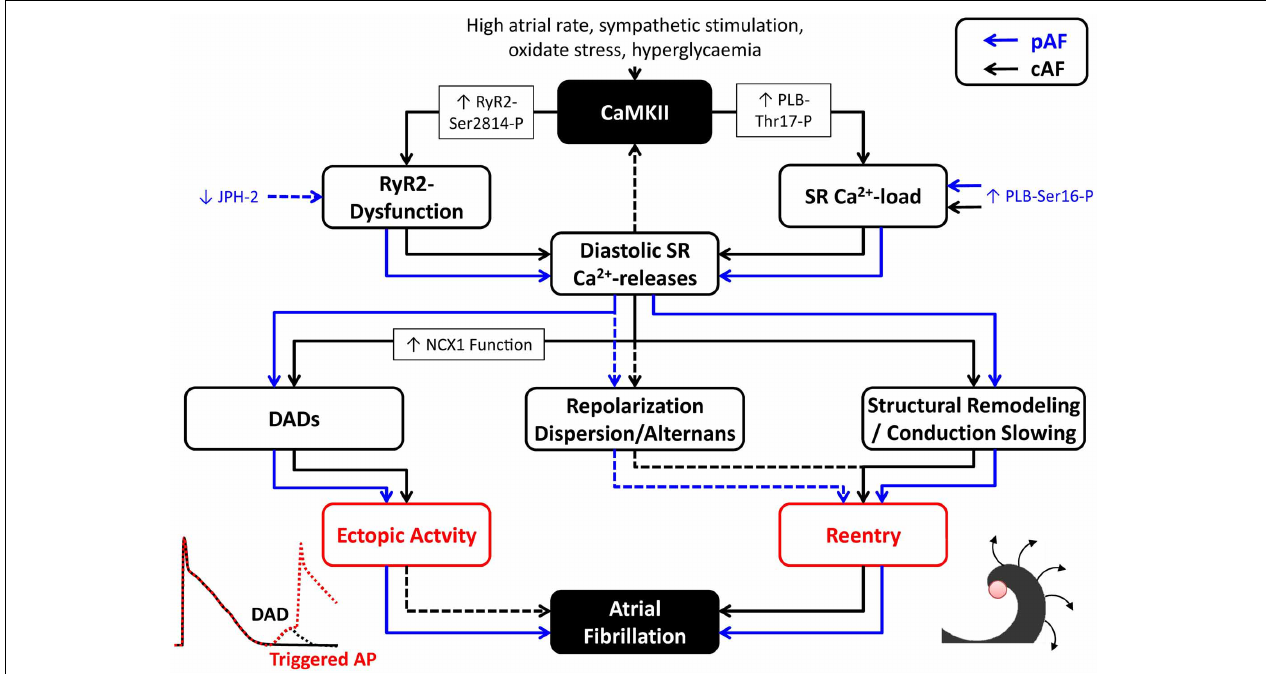
long-standing persistent, chronic AF (cAF; black lines). SR Ca 2 + -leak and diastolic SR Ca 2 + -release events can produce delayed afterdepolarizations (DADs) that contribute to ectopic activity. In addition, they can promote reentry through local repolarization abnormalities, as well as structural remodeling and conduction velocity (CV) slowing. Influences for which the proarrhythmic roles are more speculative have been indicated with dashed